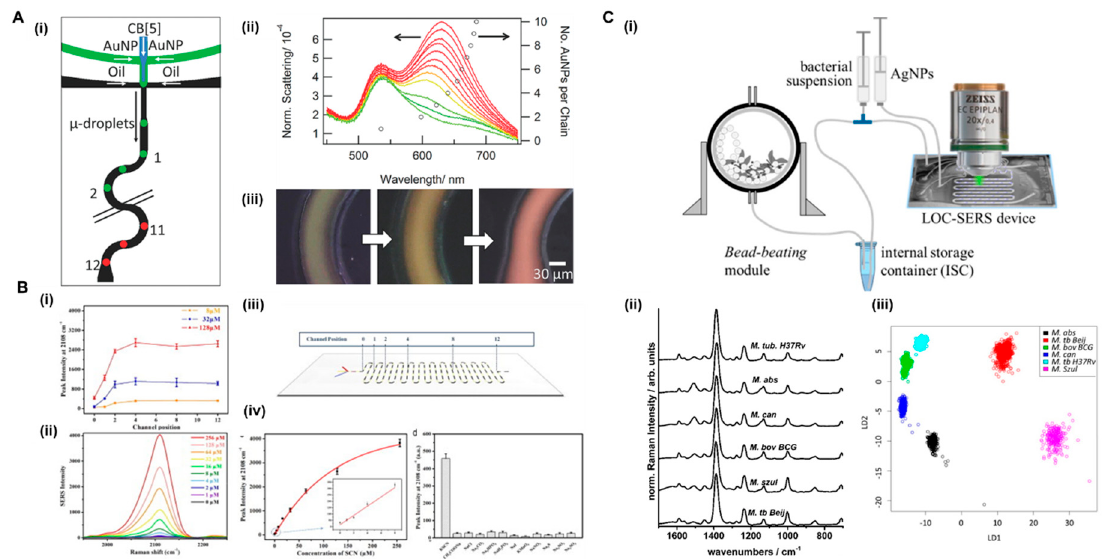
Figure 4. Microdroplets-based examples for label-free detection in microfluidics; ( A ) monitoring early-stage nanoparticle assembly in microdroplets by optical spectroscopy and SERS (i) schematic of microfluidic device used for microdroplet nanoparticle assembly experiments, (ii) dark-field scattering spectra at these positions are plotted in panel, and (iii) dark-field images from the start, middle, and end of the serpentine channel (reprinted with permission from Wiley [80]); ( B ) (i) plot of peak intensity for thiocyanate (SCN − ) at 2108 cm − 1 as a function of channel positions for the detection of 8, 32, and 128 μ M SCN − , (ii) concentration-dependent SERS spectra for SCN − detection; (iii) device positions for SERS measurements in microdroplets; (iv) plot of peak intensity at 2108 cm − 1 as a function of SCN − concentration (left) and comparison of peak intensity at 2108 cm − 1 of Au@Ag NRs mixed with different anion ions (right) (reprinted with permission from Elsevier [53]) ( C ) LOC-SERS device for bacteria detection; (i) scheme of sample preparation, including the sample lysing module (bead-beating system) for the bacterial cell disruption, the internal storage container, the syringe pump system, and the droplet-based microfluidic device mounted to the microscope stage; (ii) mean spectra recorded from three batches of six different mycobacterium species; (iii) principal component analysis-linear discriminant analysis (PCA-LDA) model trained to separate the six species data plot using a hierarchical model (reprinted with permission from Mühlig [61]. Copyright 2016 American Chemical Society).